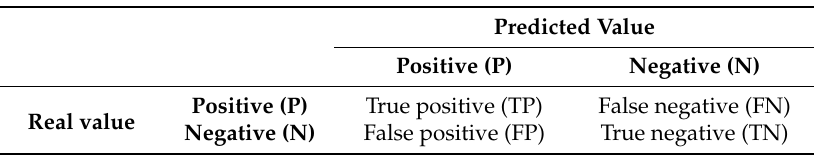
Table 7. Confusion matrix for binary